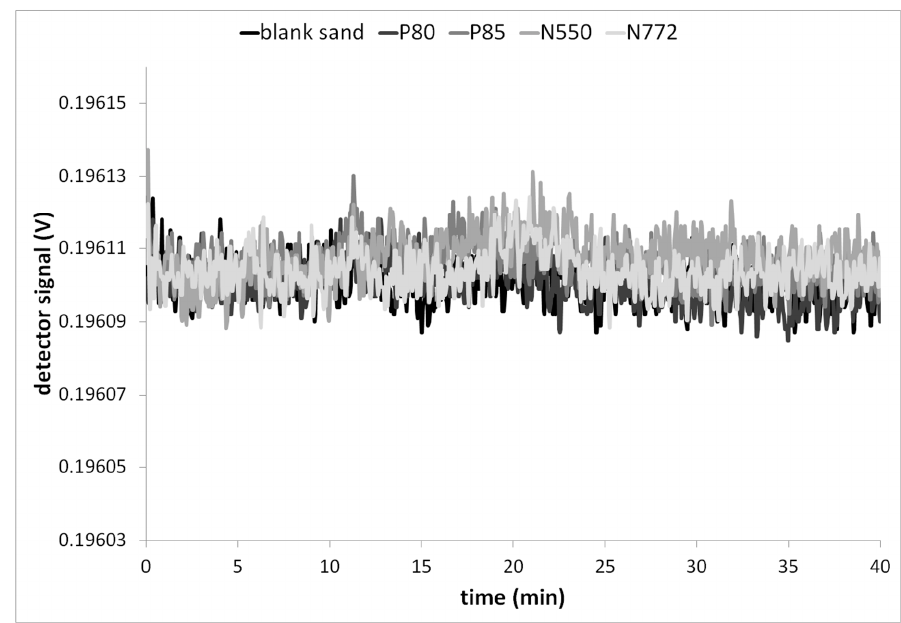
Figure 7. AF4 fractograms of the nanocomposites that were abraded for 30 min with quartz sand compared to blank quartz sand.